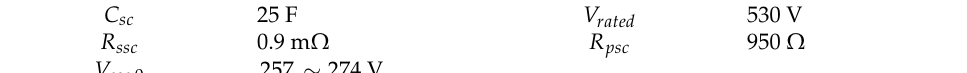
Figure 17. Pole displacement map in response to integral gain variation in VSC voltage control ( 𝑘𝑘 𝑖𝑖𝑝𝑝2 ) loops, 188 < 𝑘𝑘 𝑖𝑖𝑝𝑝2 < 560. Table 1. Parameters of the PVSC system under the study. 𝑣𝑣 𝐺𝐺